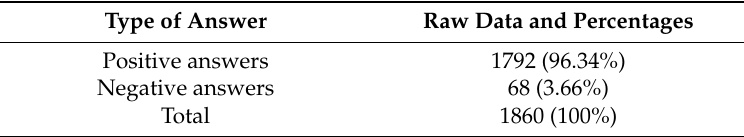
Table 4. Distribution of the answers given by female students in raw data (and % between brackets). NB: due to 16 non-answers, the total global is below 1876 (134 participants × 14 items).